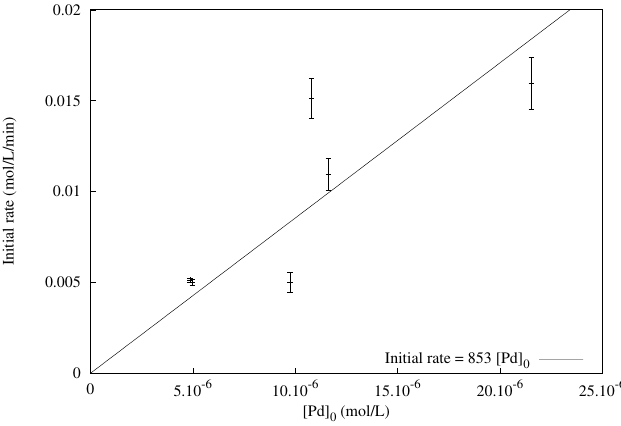
Figure 2. Effect of the initial concentration of Pd on the initial reaction rate. Conditions: 4-iodoacetophenone (0.05 mol/L, 1 eq.), phenylboronic acid (0.06 mol/L, 1.2 eq.), MeONa (0.075 mol/L, 1.5 eq.), Pd from 5 · 10 − 6 to 2.2 · 10 − 5 mol/L, ethanol (20 mL), and 60 ◦